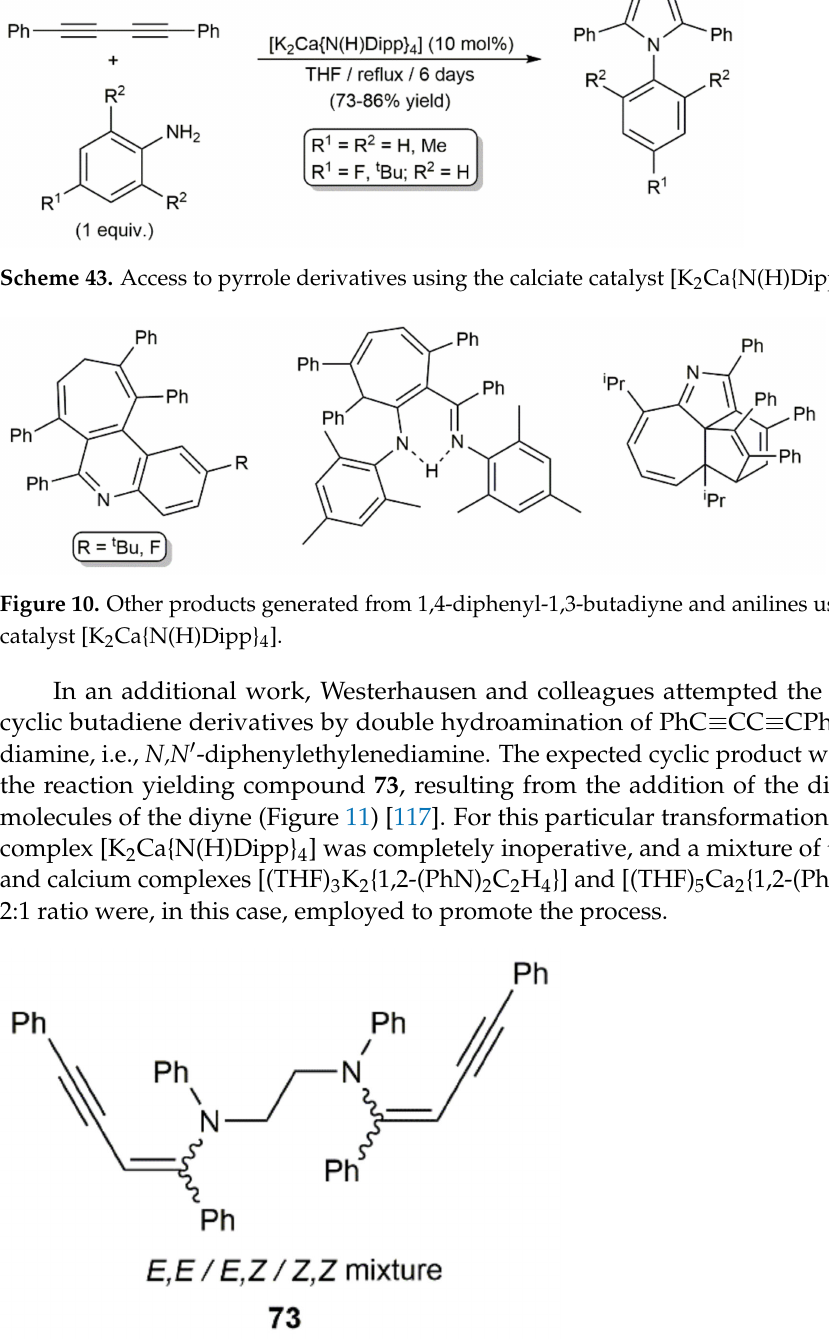
Figure 11. Structure of compound 73 generated from N,N (cid:48) -diphenylethylenediamine and 1,4-